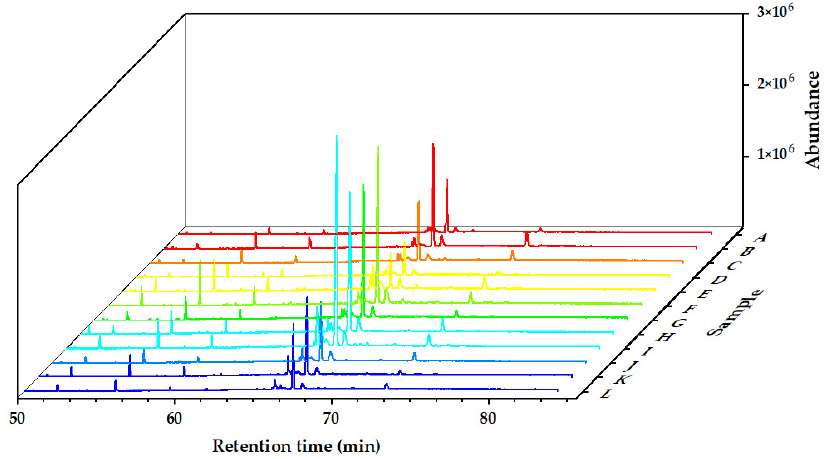
Figure 3. GC-MS chromatograms of the volatile components of the petroleum ether extractives of Alnus cremastogyne pods.